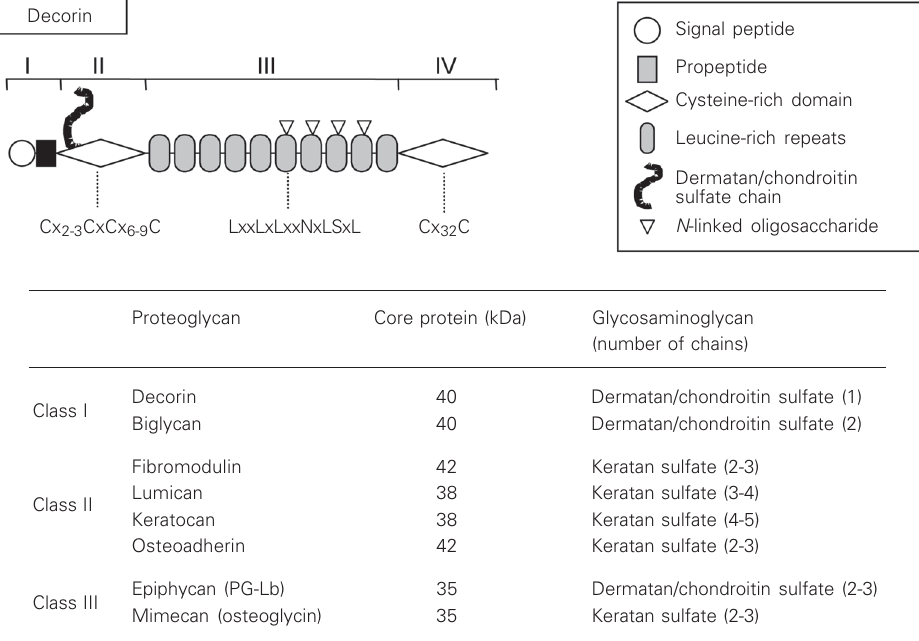
Figure 5. Domain structure of decorin, a prototype member of the leucine-rich repeat proteo- glycan family, and classification of the leucine-rich repeat proteo- glycans based on amino acid se- quence homology. Roman nu- merals indicate decorin do- mains. In addition to the gly- cosaminoglycan chain (derma- tan sulfate or chondroitin sul- fate), N -linked